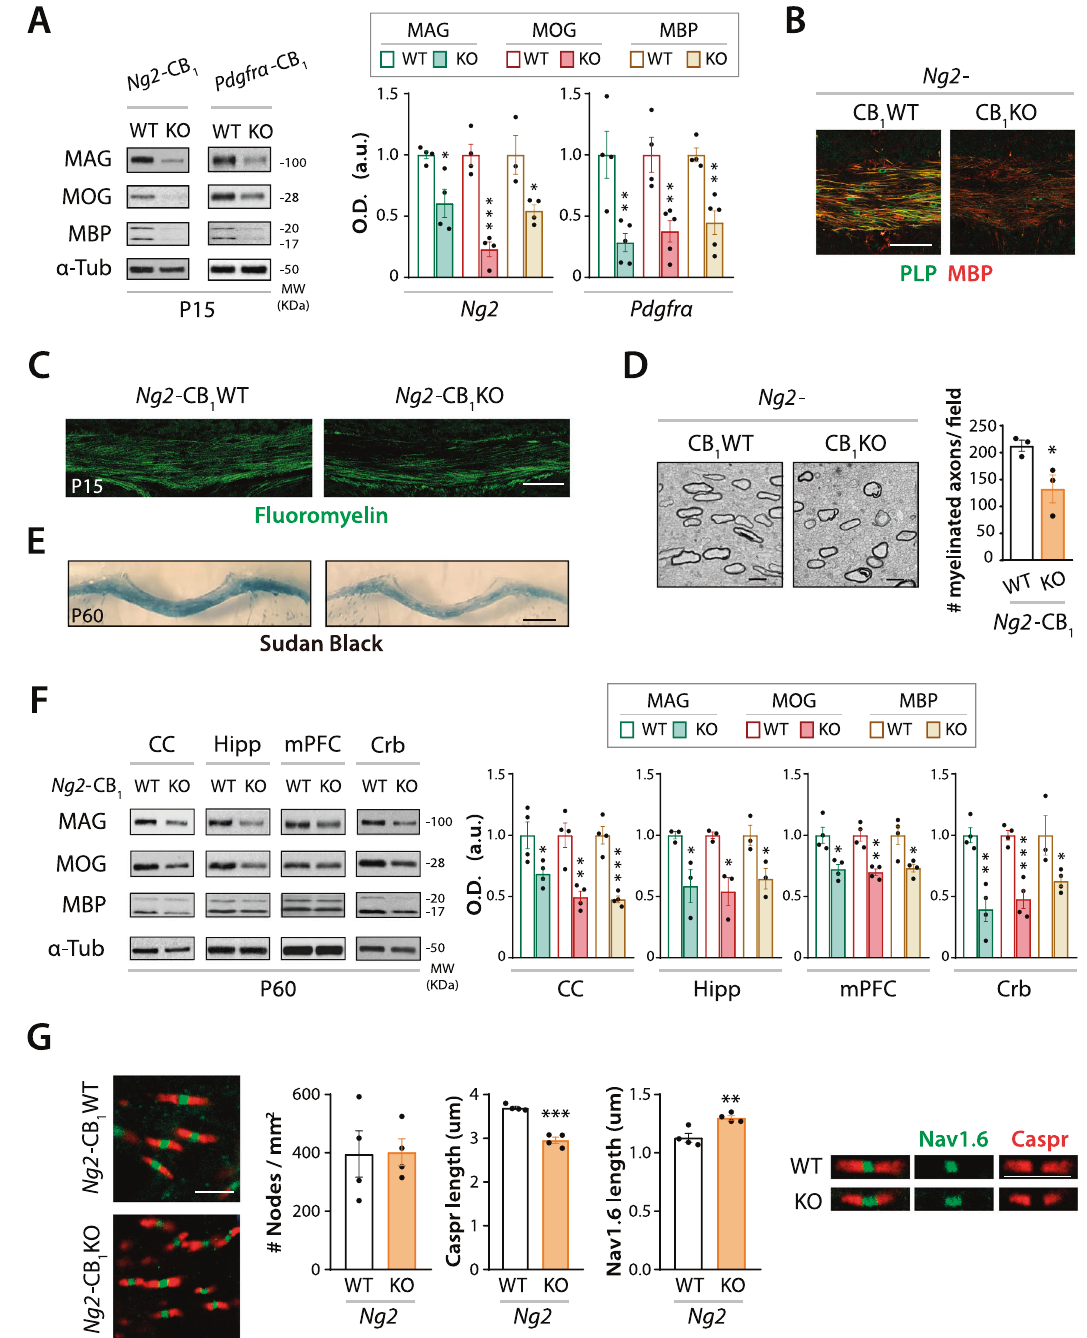
Fig. 2 Genetic inactivation of CB 1 receptor in OPCs disrupts developmental myelination. Tamoxifen-driven recombination was induced in Ng2 -CB 1 KO, Pdgfr α -CB 1 KO and control mice at postnatal day 6 (P6-P7) and tissue was analyzed in the corpus callosum (CC) at P15 and P60. A and F Western blot analysis of myelin protein levels, such as myelin-associated glycoprotein (MAG), myelin oligodendrocyte glycoprotein (MOG), and myelin basic protein (MBP) from CC extracts at P15 ( A ) or P60 ( F ), or cerebellar (Crb), hippocampal (Hipp), and medial prefrontal cortex (mPFC) extracts at P60 ( F ). Quanti fi cation of optical density (O.D.). B Immuno fl uorescence analysis of proteolipid protein (PLP) and MBP in Ng2 -CB 1 KO and Ng2 -CB 1 WT mice at P15. C Fluoromyelin staining in the CC at P15. D Electron microscopy analysis and quanti fi cation of myelinated axon density in Ng2 -CB 1 KO and Ng2 -CB 1 WT mice at P15. E Representative images of Sudan black staining in the CC of Ng2 -CB 1 KO and Ng2 -CB 1 WT mice at P60. G Immuno fl uorescence analysis and quanti fi cation of node density and paranode (Caspr) and node (Nav1.6) length in the CC of Ng2 -CB 1 KO and Ng2 -CB 1 WT at P60. Data are shown as mean ± SEM. n = 3 – 5 for A , n = 3 for D , E , n = 3 – 4 for E , F , and n = 4 for G , independent data points used per each experimental group. * p ≤ 0.05, ** p ≤ 0.01, *** p ≤ 0.001 vs Ng2 -CB 1 WT mice, by two-tailed unpaired Student ’ s t-test for A , D , E , F and G . Scale bars, 80 µm for B , 100 µm for C , 4 µm for D , 600 µm for F , and 3 µm for G .